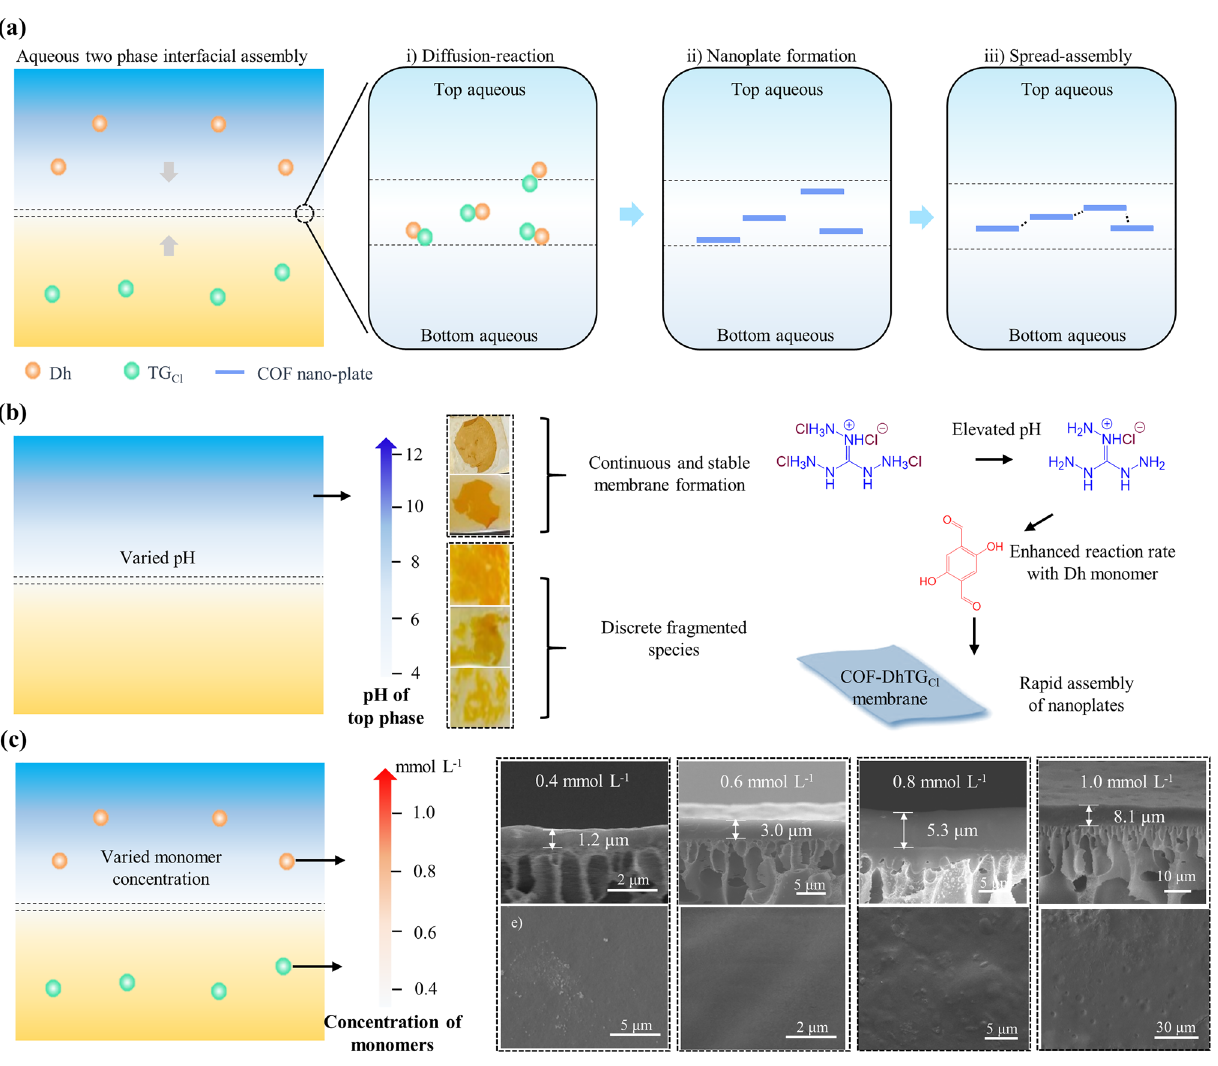
Fig. 3 Structural evolution of COF-DhTG Cl membranes. a Scheme of interfacial assembly mechanism. b Membrane formation behavior under different pH of top phase. c Membrane morphologies under different monomer